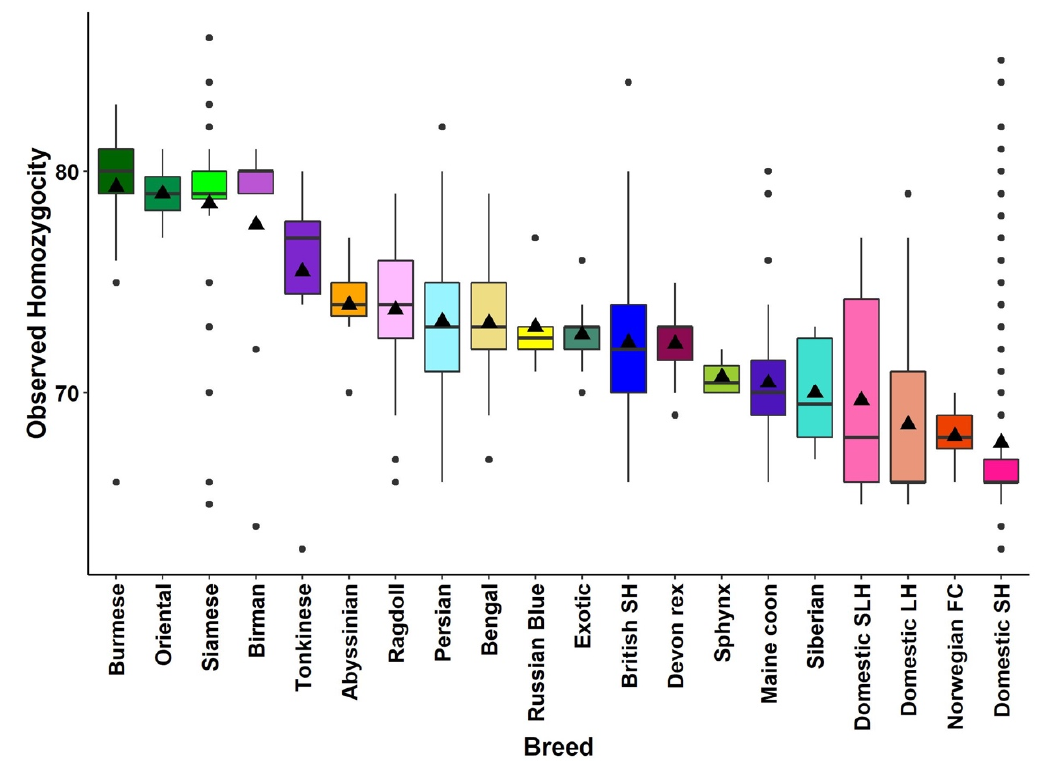
Figure A8. The observed homozygosity of all samples in the full dataset, only showing breeds included in the balanced dataset.